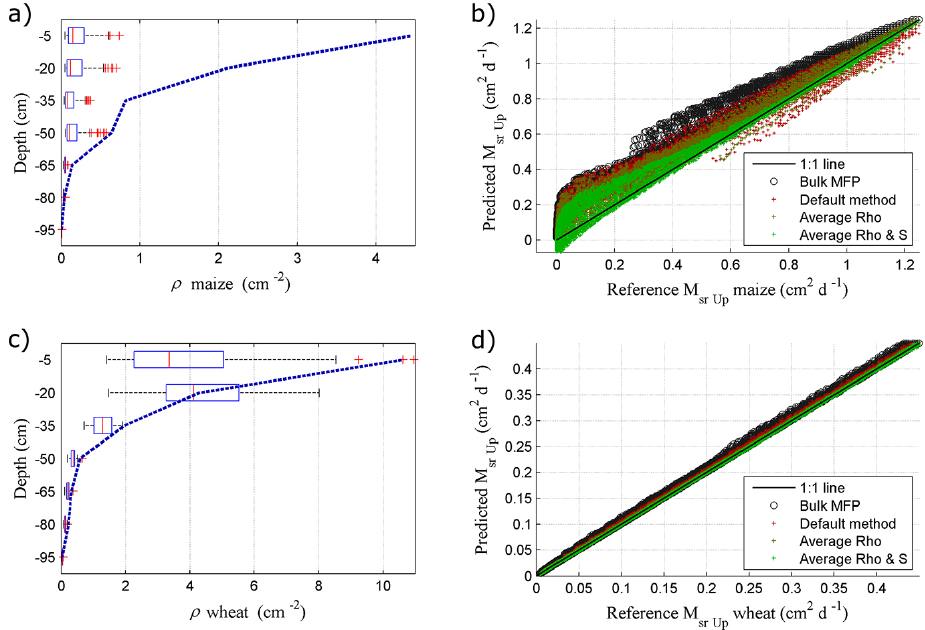
Fig. 9. System effective properties and state from the scenario “high T daily on silt loam”. Theoretical (blue dotted lines) and effective (box plots) values of ρ for maize (a) and wheat (c) . The layer’s matric flux potential at soil–root interfaces predicted using Eq. (17) with default and effective methods, compared with reference values, for maize (b) and wheat (d)